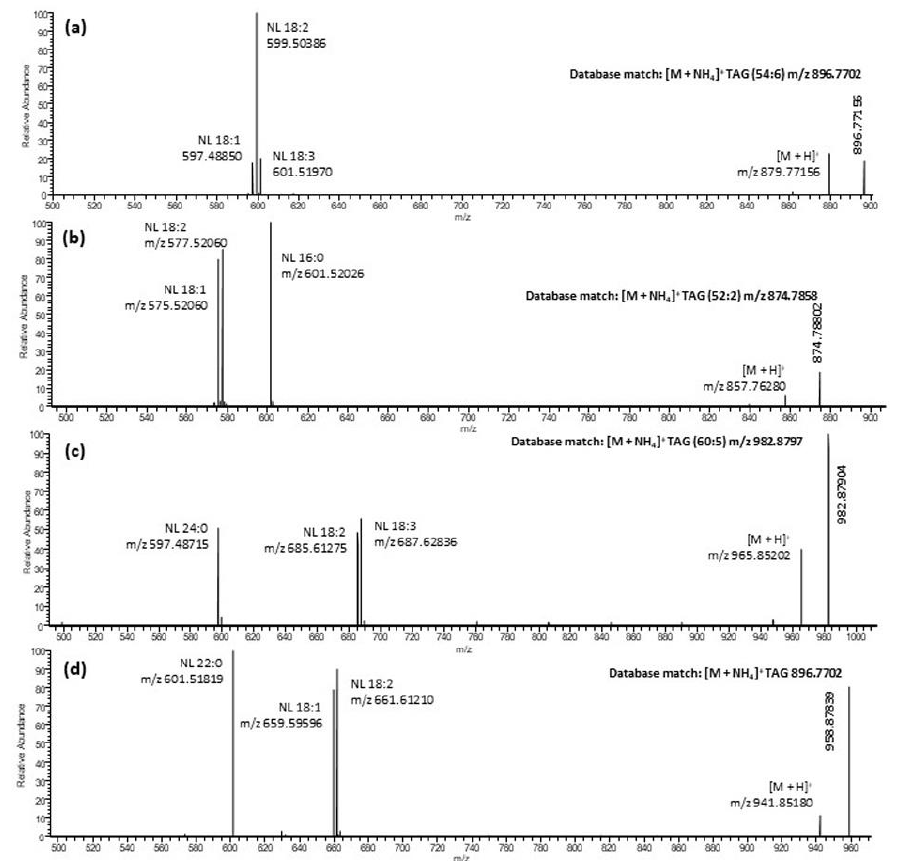
Figure 5. Representative mass spectrum of TAGs with fragmentation ions corresponding to neutral loss (NL). ( a ) TAG (54:6) 18:3/18:2/18:1, ( b ) TAG (52:3) 18:2/18:1/16:0, ( c ) TAG (60:5) 24:0/18:3/18:2 and ( d ) TAG (58:3) 22:0/18:2/18:1 with their fragmentation ions.